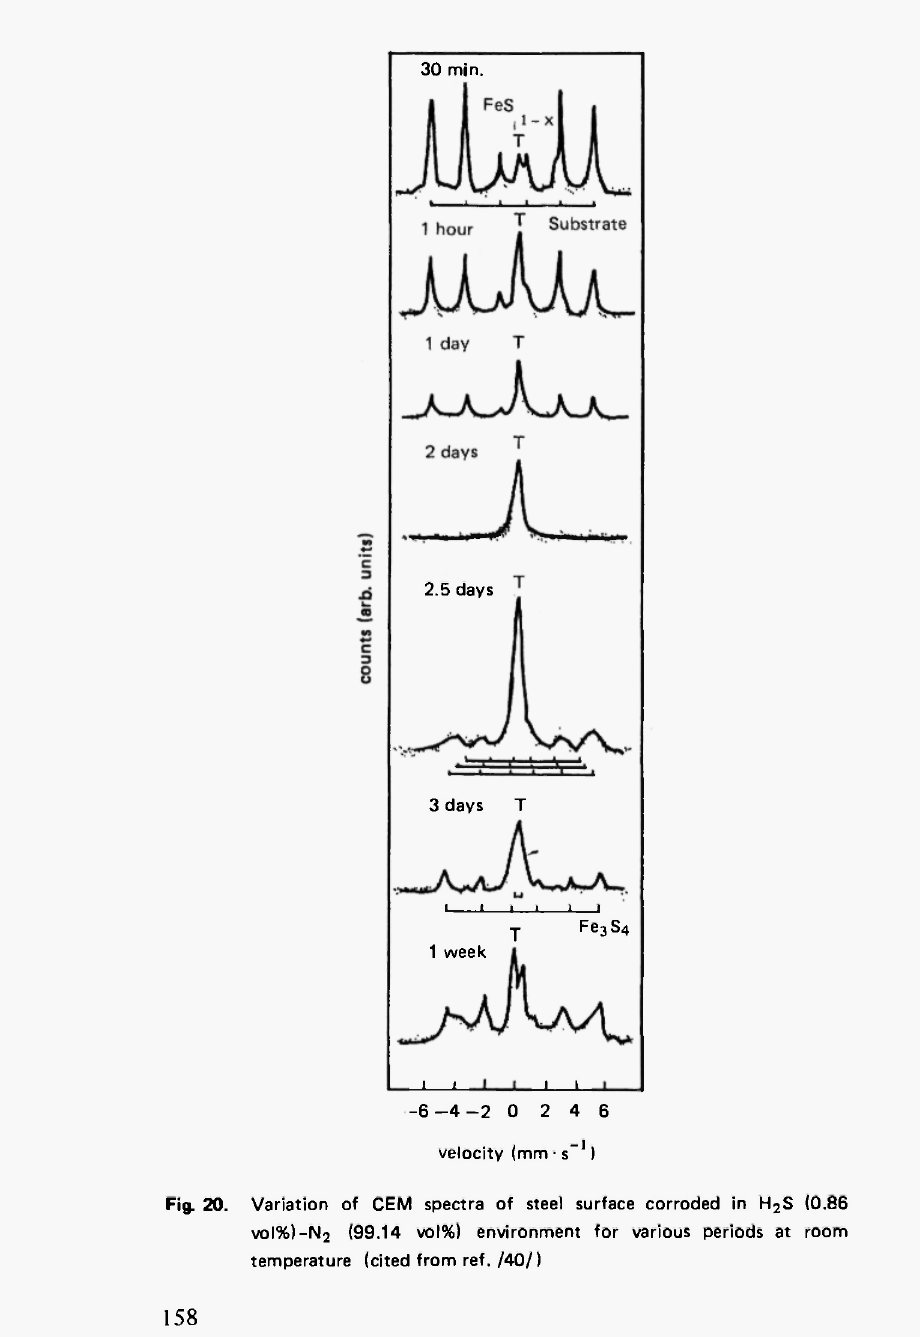
Fig. 20. Variation of CEM spectra of steel surface corroded in H 2 S (0.86 vol%)-Nj (99.14 vol%) environment for various periods at room temperature (cited from ref./40/)